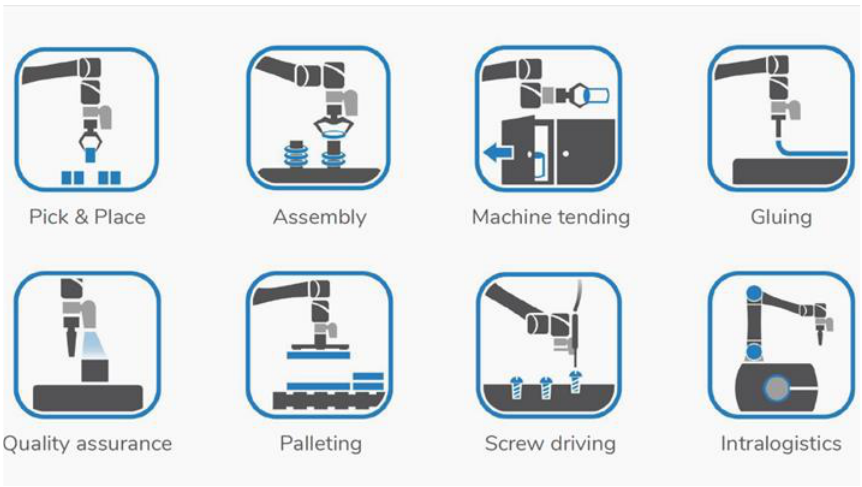
Figure 4. An example application of cobots in the manufacturing industry [21].